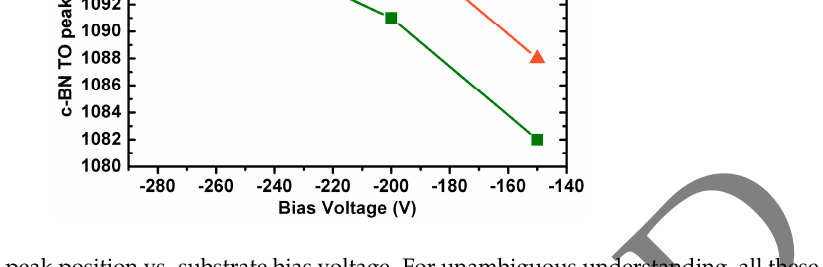
Figure 6. c-BN TO peak position vs. substrate bias voltage. For unambiguous understanding, all these films are 100% cubic.